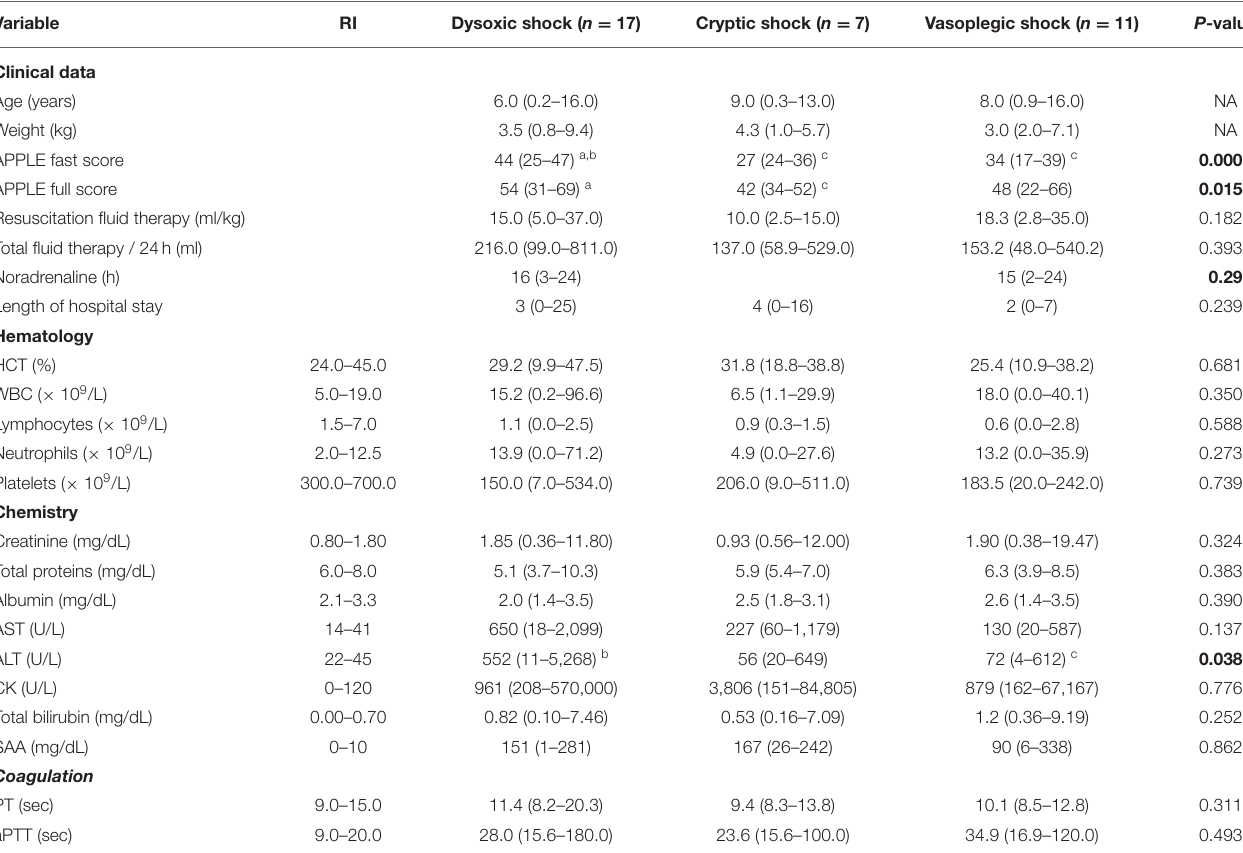
TABLE 3 | Clinical and clinicopathological variables in cats with dysoxic shock, cryptic shock, and vasoplegic shock.